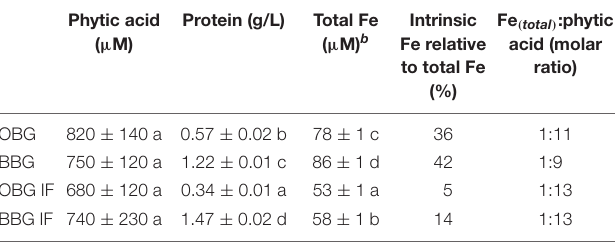
a Phytic acid and protein are given as intrinsic concentrations in the 50 mL solution, while intrinsic iron (Fe) is given relative to the total iron content. Different letters indicate significant differences (p < 0.05). b Absolute total iron concentration = 50 µ M extrinsic iron + intrinsic iron from the extract